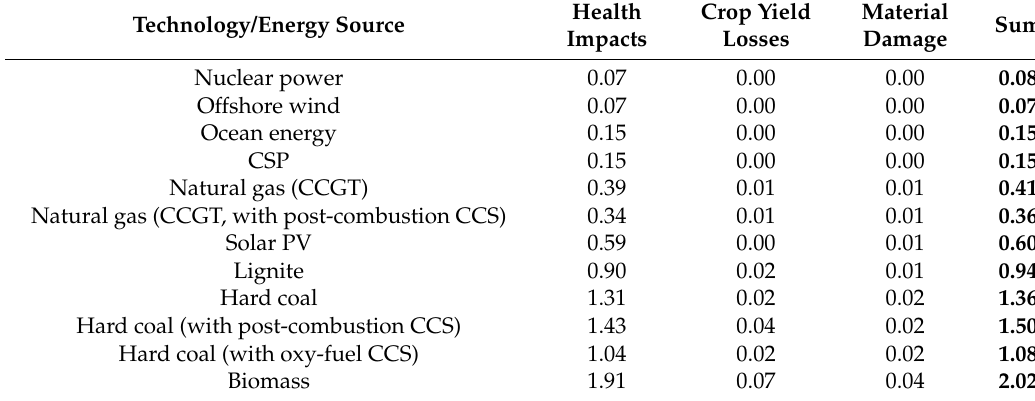
Health Crop Yield Material Sum Impacts Losses Damage